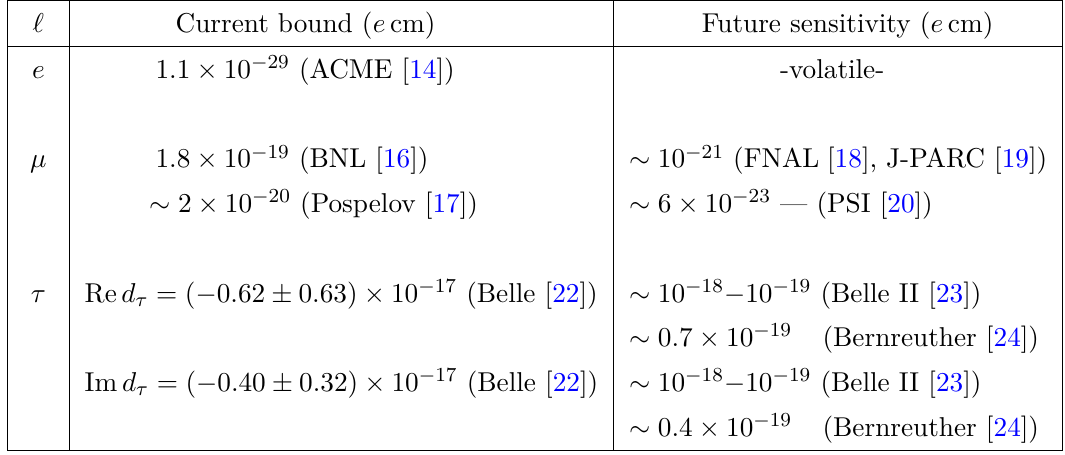
Table 1 . Present bounds and future sensitivities for EDM of charged leptons, | d ‘ |